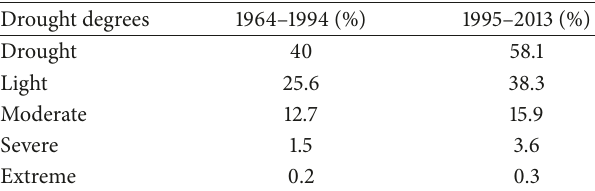
Table 2: The comparison of drought happening rates between 1964–1994 and